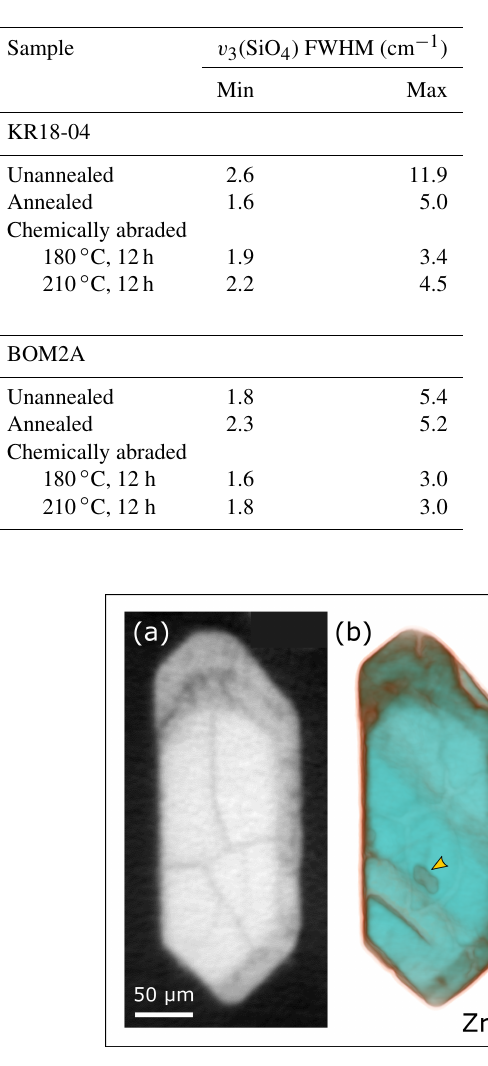
Figure 8. µCT images of a zircon with density zoning. (a) A single 2D µCT image slice of an annealed – but not leached – AS3 grain with a dark, low-density damaged rim and a light, high-density crys- talline core. (b) Semi-transparent 3D rendering of the µCT image stack for the same grain. High-density zircon is teal, and lower- density material is orange–brown. The arrow marks an interior in- clusion. The faint stripes are surface indents of surficial inclusions not